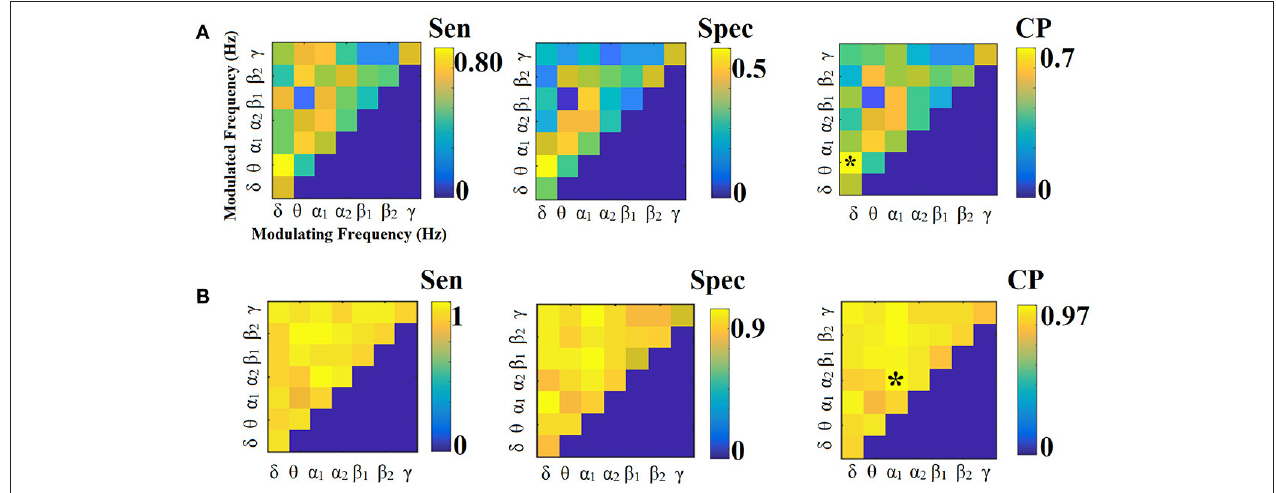
FIGURE 4 | Sensitivity, specificity, and classification performance of iPLV using centroid ROI representation and edge-weights approach of each SL-FCG. (A) Sensitivity, specificity and classification performance for the LOOCV. (B) Sensitivity, specificity and classification performance for the 5-fold CV. * denotes the best CP for each CV scheme. Sen, sensitivity; Spec, specificity; CP, classification performance.